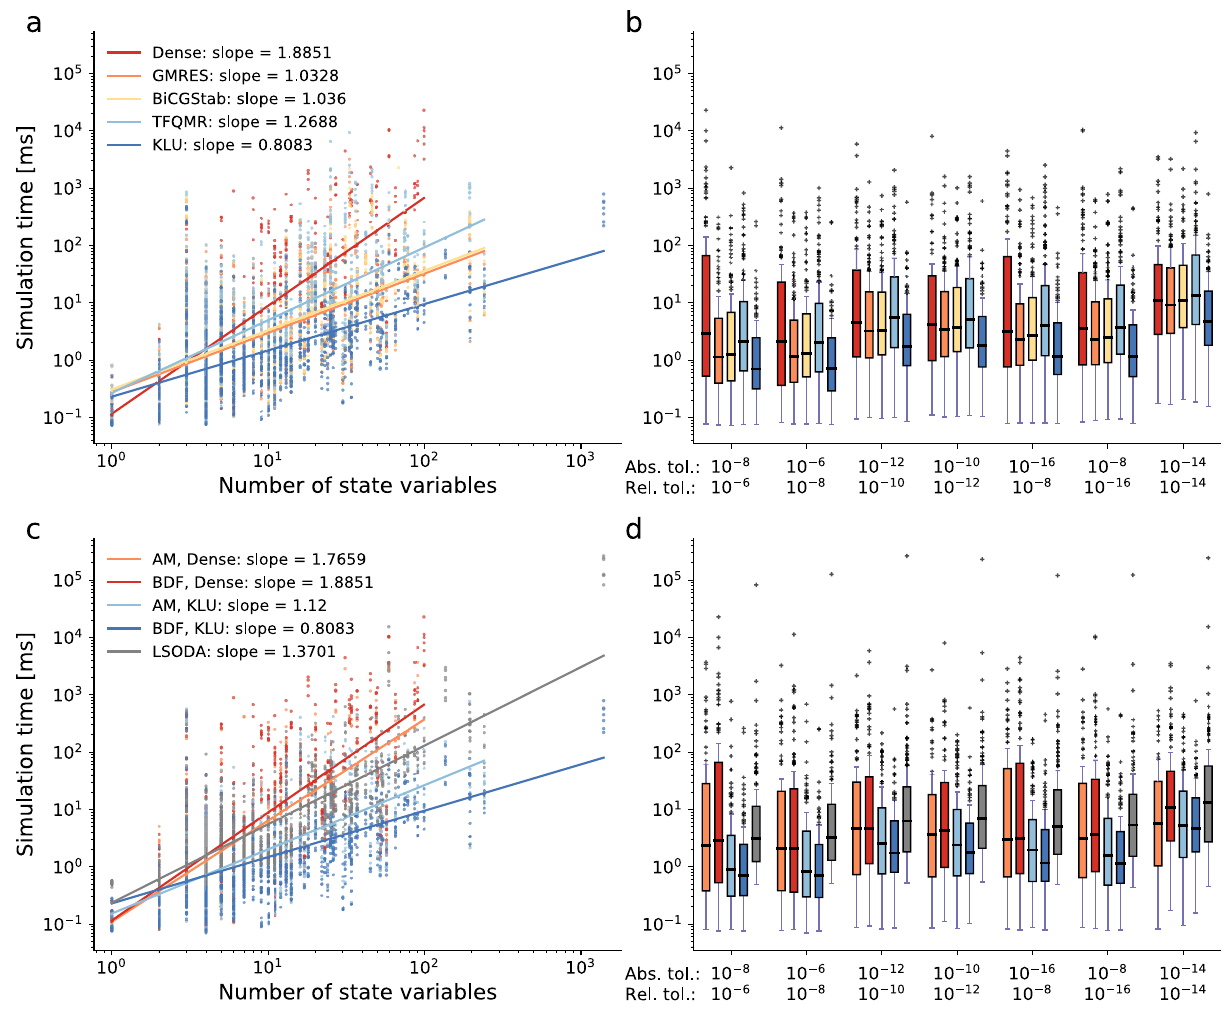
Figure 3. Linear solvers. Scaling behavior and computation time comparison of the linear solvers and integration algorithms. ( a ) Each point depicts the simulation time of one model (median of 25 repetitions) with one solver setting: BDF integration algorithm, Newton-type non-linear solver, one tolerance combination, and one linear solver (which are color-coded). Results are shown for seven tolerance combinations and five linear solvers, meaning there are 35 points for each model. The accompanying linear regressions display the scaling behavior with respect to the number of state variables. ( b ) Box plot of the simulation times, separated by the tolerance combination in addition to the linear solver, using the BDF integration algorithm and the Newton- type non-linear solver. ( c ) Scaling behavior of the different integration algorithms using the Newton-type method and the direct linear solvers with the same setup as in subfigure ( a ). ( d ) Box plot of the simulation times for the different integration algorithms using the Newton-type method and the direct linear solvers with the same setup as in subfigure